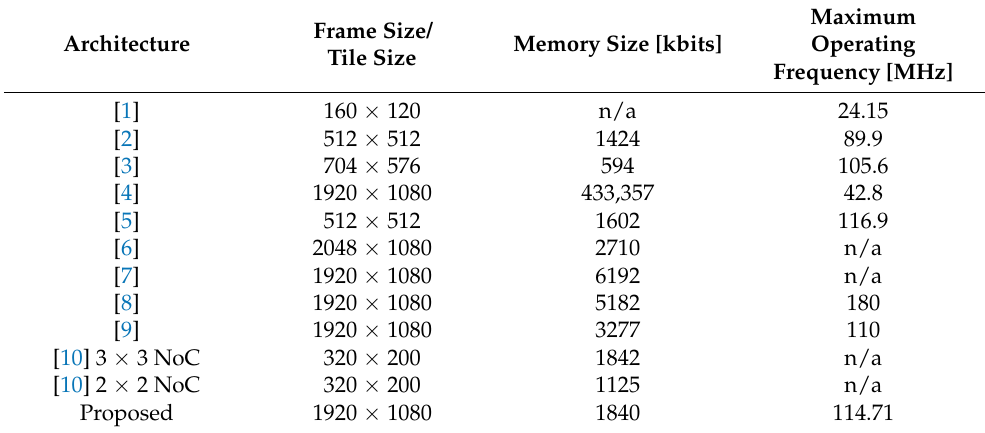
Table 10. Comparison of FPGA synthesis results for various architectures of digital image